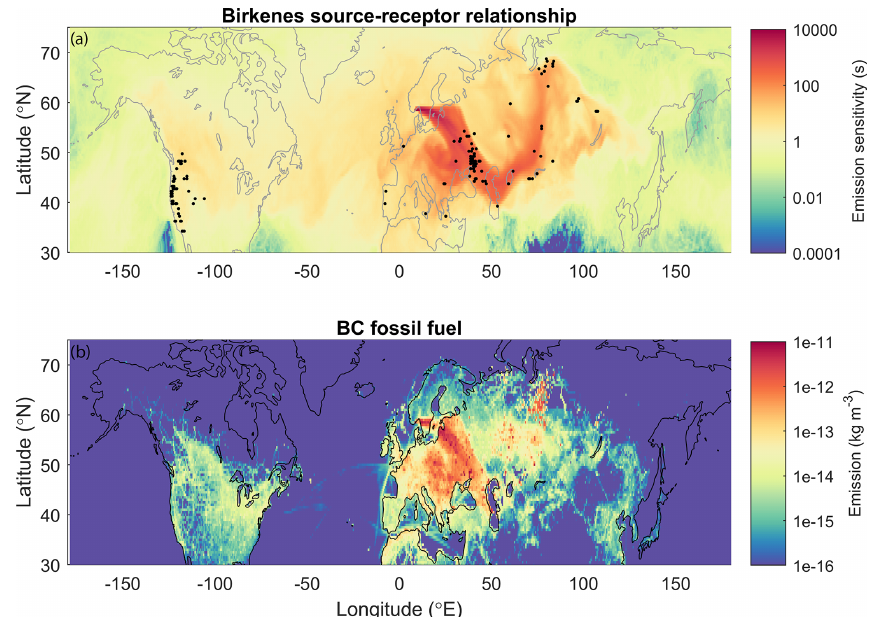
Figure 10. BC source–receptor relationship at Birkenes (2 October 2020 at 00:00 to 4 October 2020 at 00:00) modelled with FLEXPART in backwards mode (a) and BC fossil fuel emissions (b) . Markers in the top panel indicate locations with BC emissions from biomass burning that contribute > 0 . 1ngm − 3 to BC concentrations at Birkenes. Only emissions that contribute to the modelled concentrations at Birkenes are included in the lower panel. The source–receptor relationship includes air masses up to 100m above ground